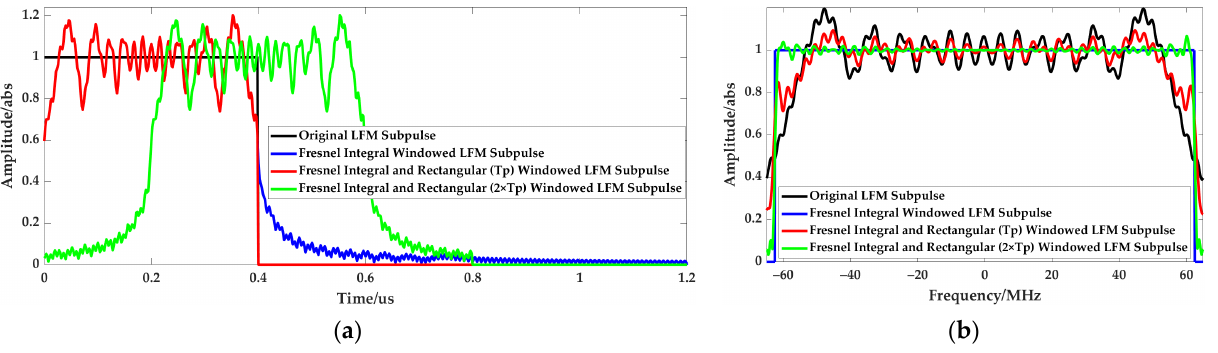
Figure 9. ( a ) Time-domain waveform of original LFM subpulse and its Fresnel integral windowed subpulse; ( b ) corresponding spectrums of the subpulse in ( a ). subpulse; ( b ) corresponding spectrums of the subpulse in ( a